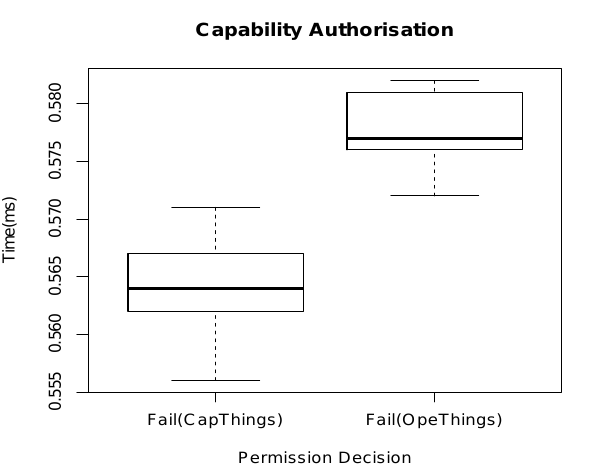
Figure 10. The capability authorisation time for condition success and failure. ‘Success(ts,con)’represents the time taken when condition returns true after all previous checks have succeeded.Similarly‘Fail(ts,con)’representsthe timetakenwhen the conditionis not valid but all previouscheckssucceeded. three conditions is 2.88ms ( µ = 2.885, σ = 0.003)